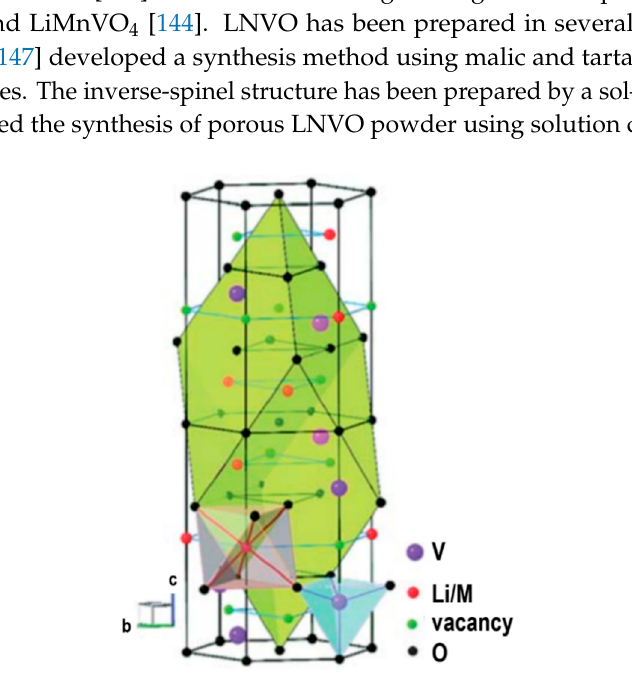
Figure 4. Crystal structure of LiMVO 4 (M = Ni or Co). Reprinted from ref. [151] with permission of The Royal Society of Chemistry.